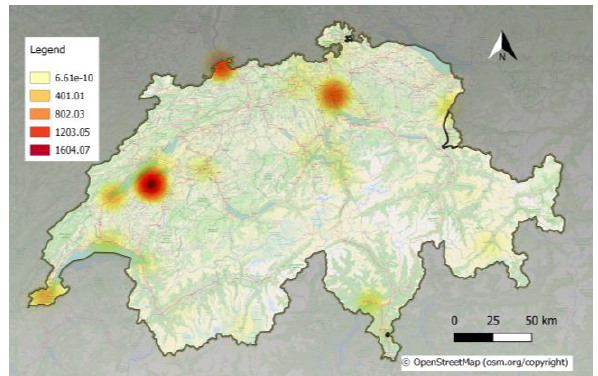
Figure 6: Density map of the Flickr images with bird tags The frequency of observations within land cover classes is